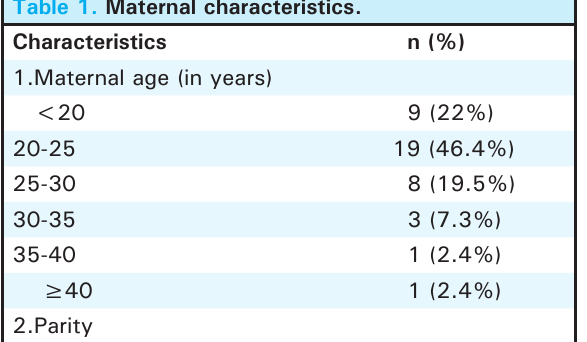
Table 1. Maternal characteristics.